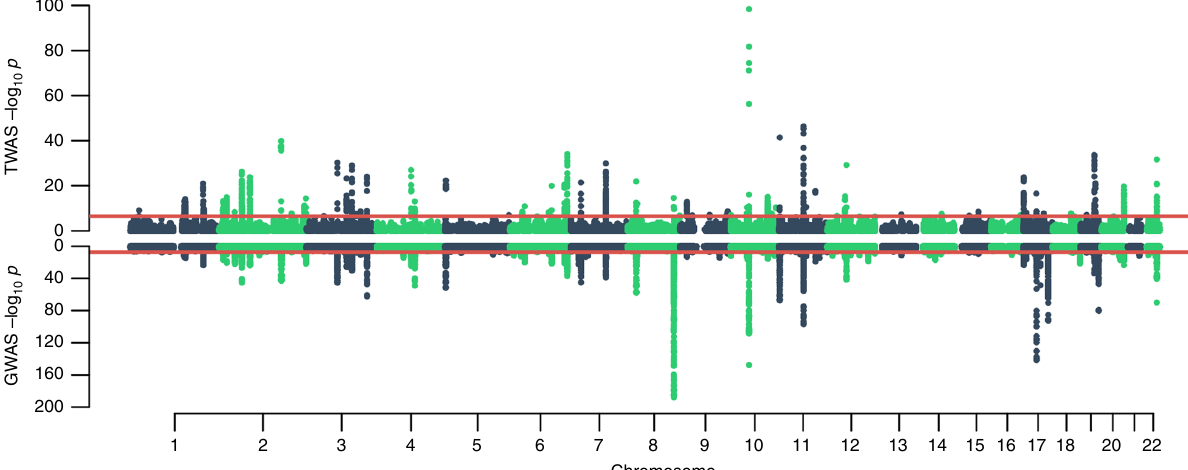
Fig. 2 OncoArray PrCa TWAS and GWAS. The top fi gure is the TWAS Manhattan plot. Each point corresponds to an association test between predicted gene expression with PrCa risk. The red line represents the boundary for transcriptome-wide signi fi cance (4.58 × 10 − 7 ). The bottom fi gure is the GWAS Manhattan plot where each point is the result of a SNP association test with PrCa risk. The red line corresponds to the traditional genome-wide signi fi cant boundary (5 × 10 − 8